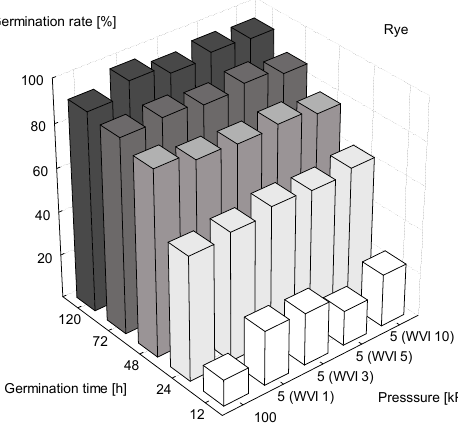
Figure 6. The germination capacity of rye grain over time, depending on the impregnation method (WVI 1—1 cycle of WVI, WVI 3—3 cycles of WVI, WVI 5—5 cycles of WVI, WVI 10—10 cycles of WVI).